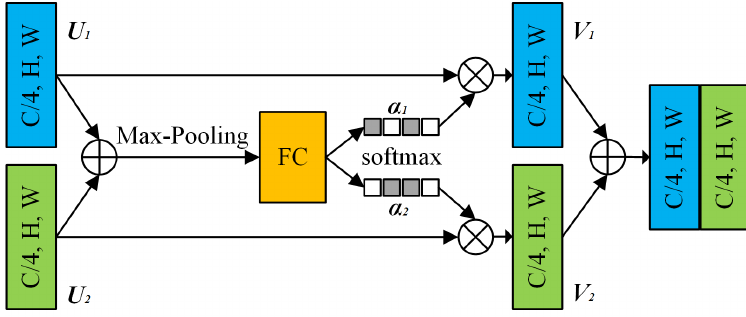
Figure 3. Split-attention block (only two branches are shown for